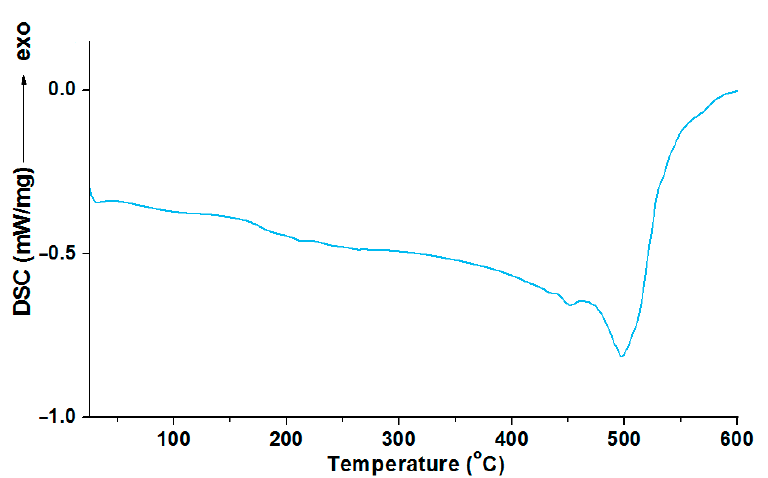
Figure 10. The curve of DSC analysis for bisphenol Z polysulfone.